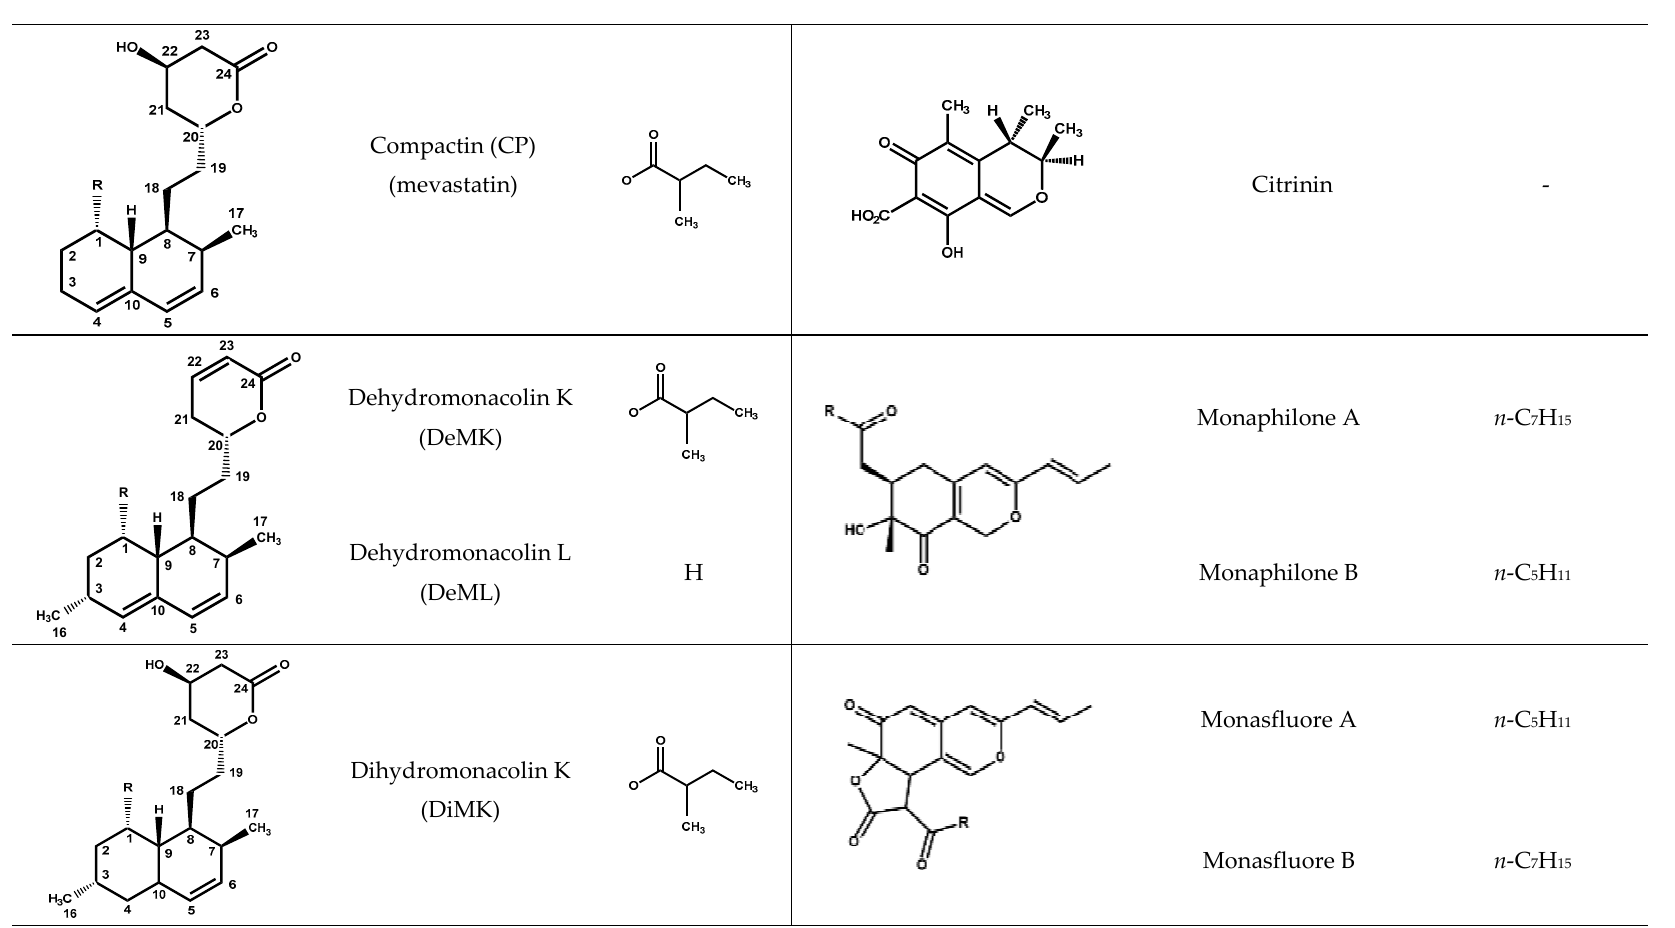
Figure 2. Chemical structures of monacolins and pigments discussed in this study.